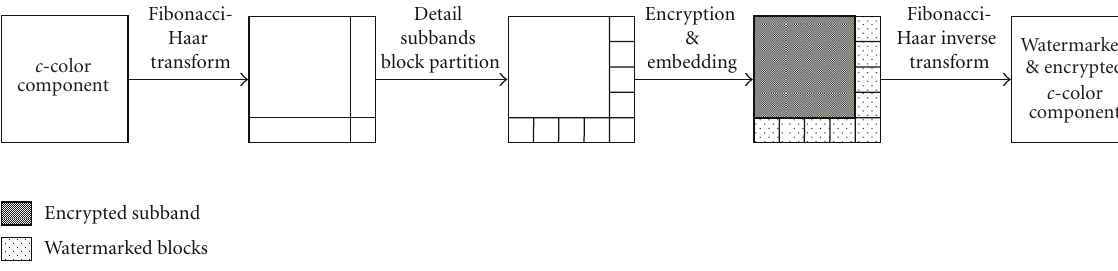
Figure 4: Watermarking and encryption method for each color component.